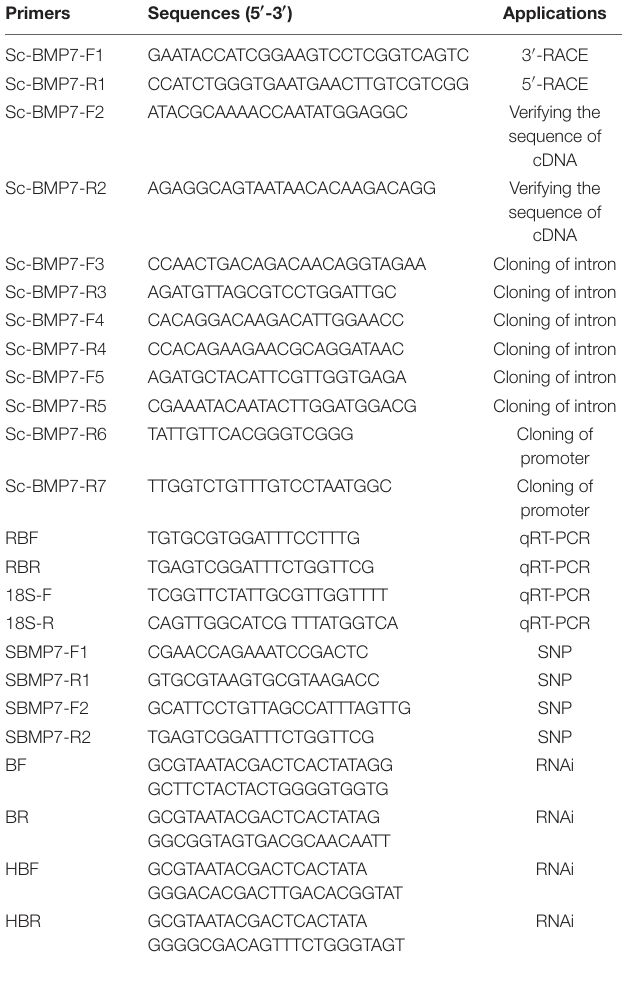
TABLE 1 | Primers and sequences of the